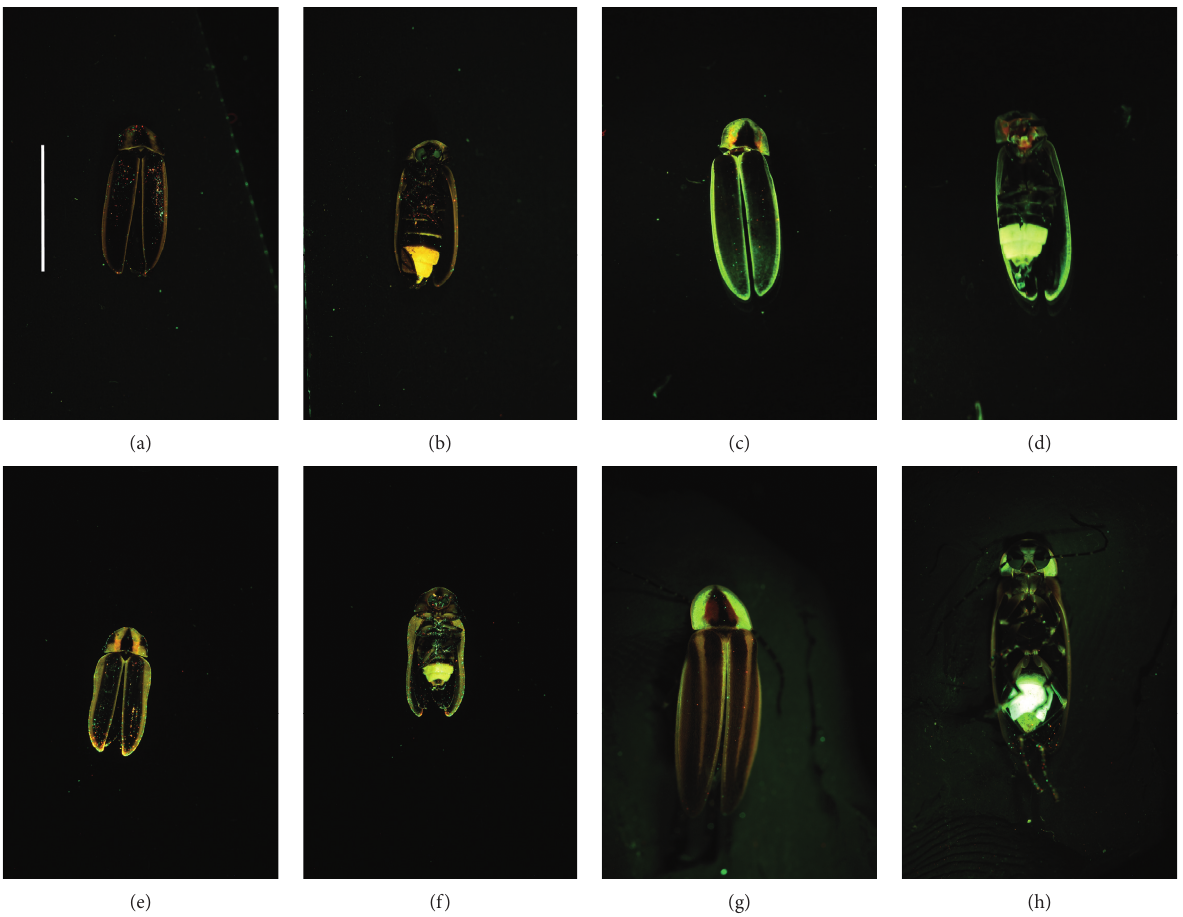
Figure 1: Dorsal and ventral fluorescence in Pyractomena linearis (a and b), Pyractomena dispersa (c and d), Pyractomena angulata (e and f), and Photuris versicolor (g and h). Specimens were photographed under white light, and under blue light using a yellow filter. Blue light was supplied by a NIGHTSEA Model SFA Royal Blue light emitting at 440–460nm, using a NIGHTSEA yellow barrier filter to screen. Scale bar represents approx.